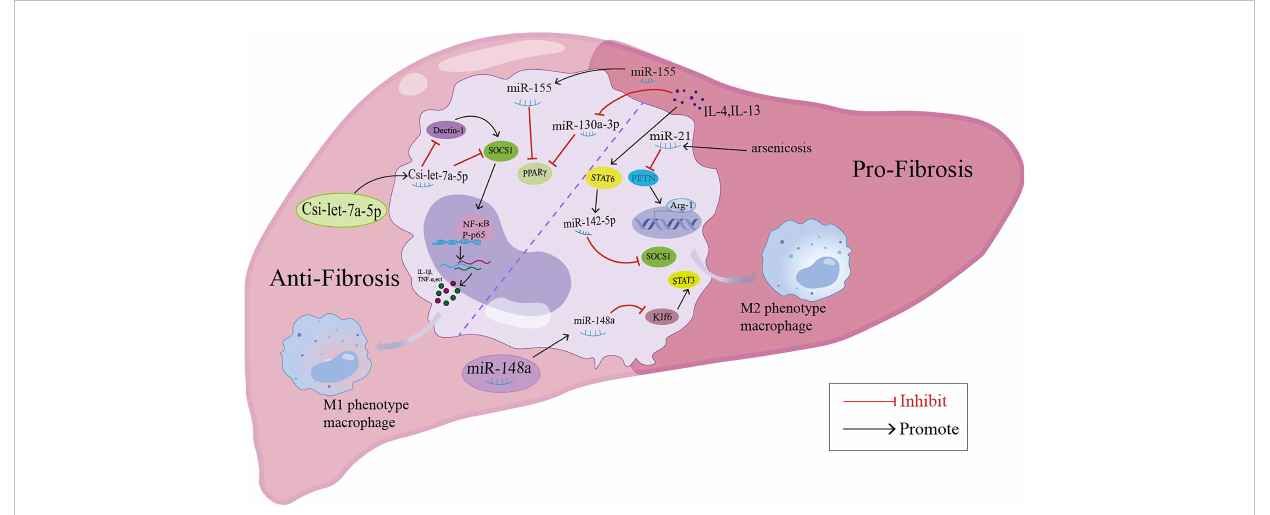
FIGURE 2 miRNAs modulate the macrophage polarization and participate in the liver fi brosis through different signaling